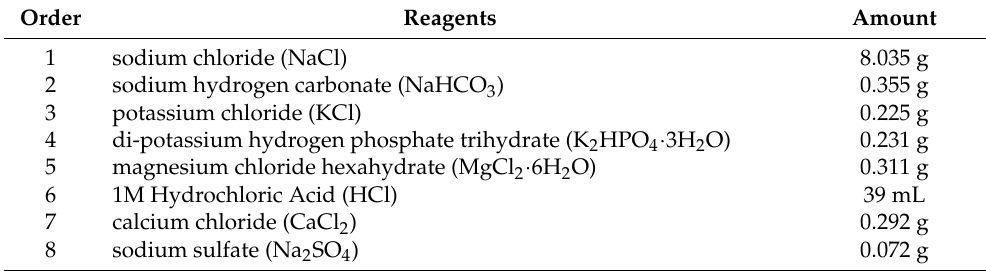
Table 1. Order and amount of reagents used for preparing 1 L SBF solution (pH